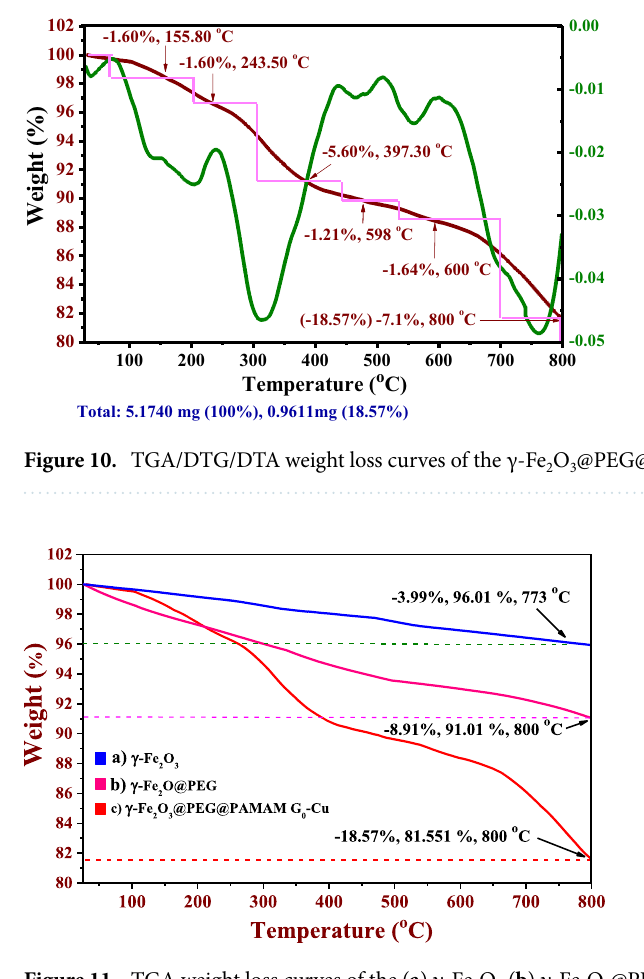
Figure 11. TGA weight loss curves of the ( a ) γ-Fe 2 O 3 ( b ) γ-Fe 2 O 3 @PEG ( c ) γ-Fe 2 O 3 @PEG@PAMAM G 0 -Cu.